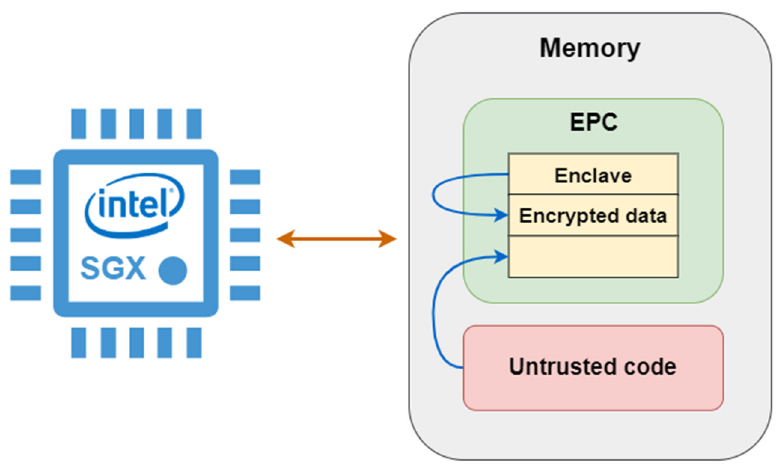
Figure 1. Isolation execution mechanism.